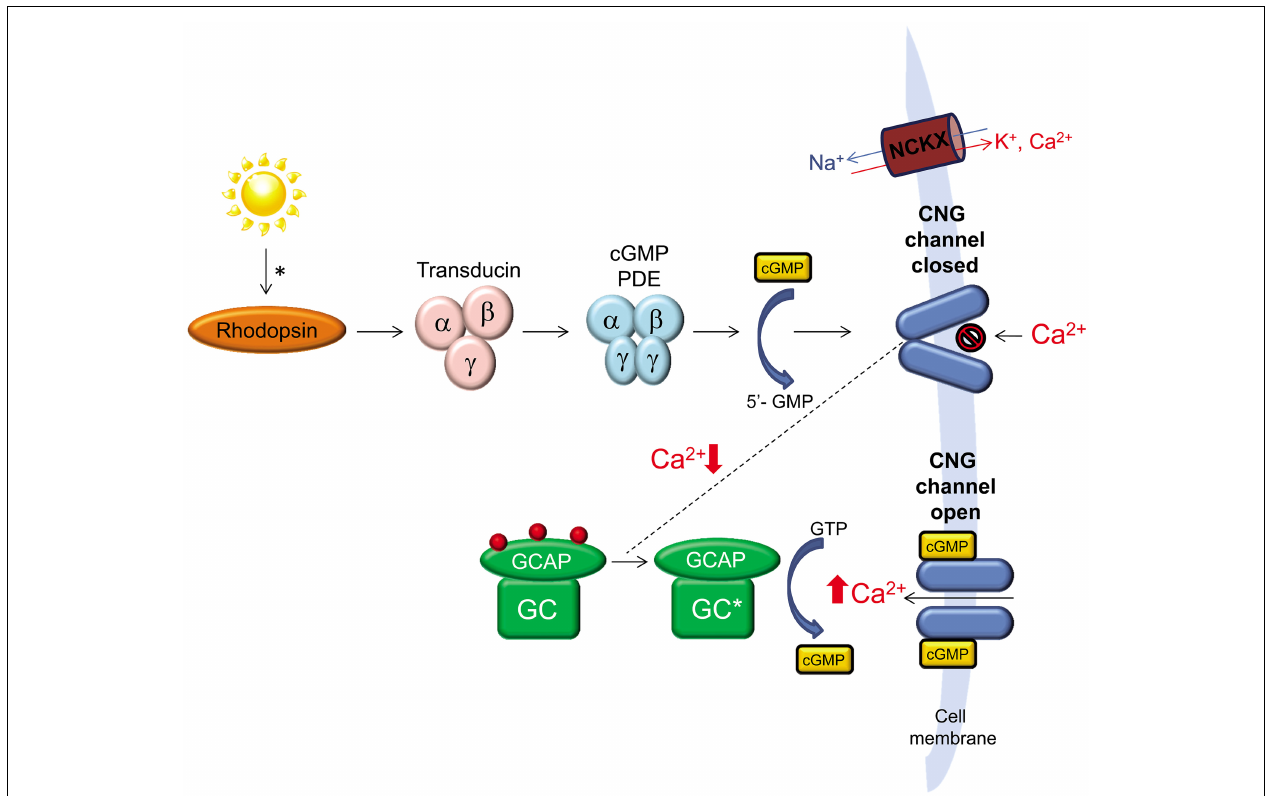
FIGURE 1 | The role of retinal guanylate cyclase (retGC) in phototransduction. A photon of light activates rhodopsin initiating a cascade of events, the end result of which is reduction of cGMP, closure of cGMP-gated channels and reduction of intracellular Ca 2 + in photoreceptor